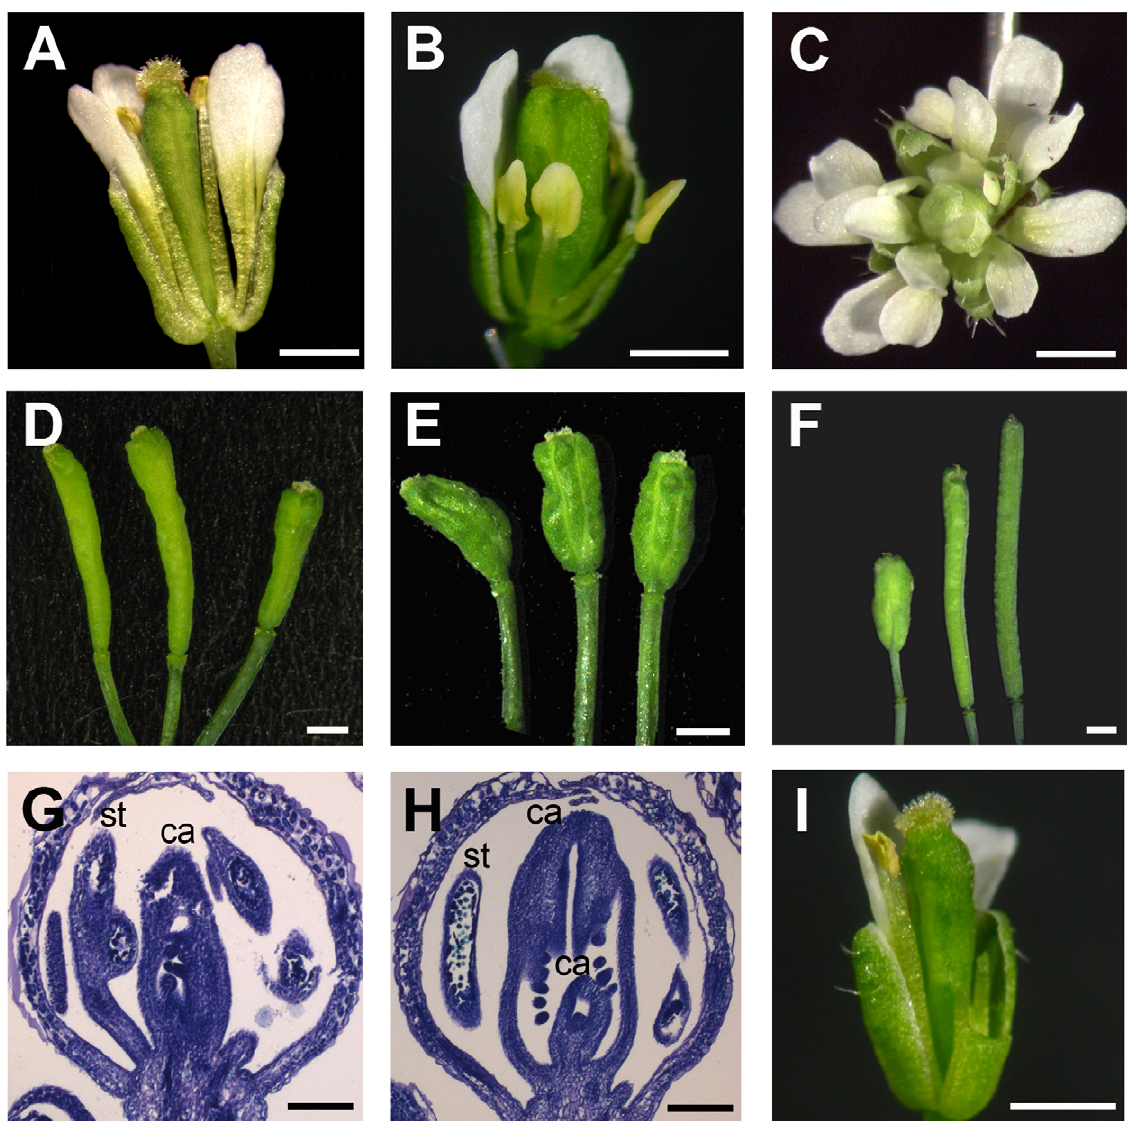
Figure 1. hen6 ( ago10-12 ) and hen7 ( ag-10 ) mutations enhance hua1hua2 . (A) A hua1 hua2 flower with a gynoecium that was slightly enlarged at the top. (B) A hua1 hua2 hen6 (or hua1 hua2 ago10-12 ) flower with petaloid stamens and a bulged gynoecium containing ectopic floral organs inside. (C) A hua1 hua2 hen7 (or hua1 hua2 ag-10 ) flower that resembled that of an ag null mutant in that the third whorl stamens were transformed into petals and that the sepal-petal-petal pattern was reiterated. (D) Siliques of hua1 hua2 . (E) Siliques of hua1 hua2 ago10-12 . (F) A representative silique of hua1 ag-10 (left), hua1 ag-10 plants carrying the pAG::AG-GFP transgene (middle), and L er (right). (G, H) Longitudinal sections of hua1 hua2 and hua1 hua2 ago10-12 stages 10-11 flowers. An ectopic floral meristem inside the fourth whorl carpels was present in hua1 hua2 ago10-12 (H) but not hua1 hua2 (G). ca, carpel; st, stamen. (I) A hua1 hua2 ago10-12 flower carrying AGO10 genomic DNA, which rescued the floral determinacy and homeotic defects of hua1 hua2 ago10-12 . Some outer whorl organs were removed to expose the gynoecia in (A), (B), and (I). Scale bars, 50 m m in (G), (H) and 1 mm in all other panels.